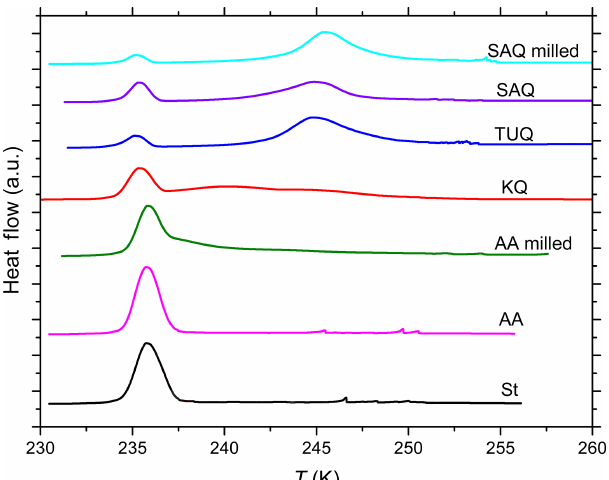
Figure 1. DSC thermograms of various quartz and amorphous sil- ica particles suspended in pure water. St: Stöber silica (10wt%); AA: Alfa Aesar silica (10wt%); AA milled: milled Alfa Aesar silica (10wt%); KQ: quartz sample from Kaufmann et al. (2016) (8wt%–9wt%); TUQ: TU Vienna quartz (5wt%); SAQ: Sigma- Aldrich quartz (5wt%, milled by Sigma-Aldrich); SAQ milled: ad- ditionally milled Sigma-Aldrich quartz (5wt%). All curves are nor- malized such that the total areas under the heterogeneous plus ho- mogeneous freezing curves sum up to the same